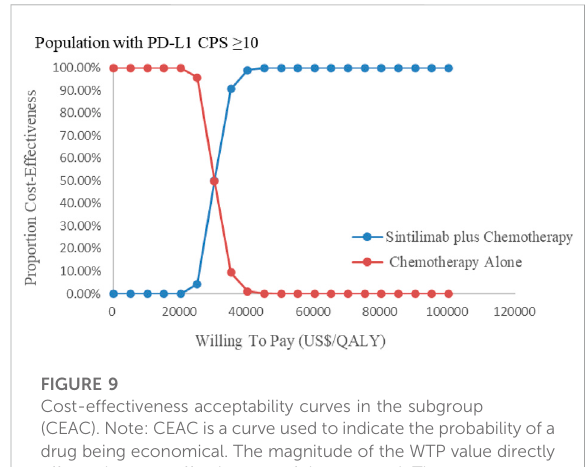
FIGURE 9 Cost-effectiveness acceptability curves in the subgroup (CEAC). Note: CEAC is a curve used to indicate the probability of a drug being economical. The magnitude of the WTP value directly affects the cost-effectiveness of the protocol. The acceptable curve shows the percentage of the cost-effectiveness of the simulation by using different treatment options, that is, the function of the relative change in the cost effect is the ICER threshold